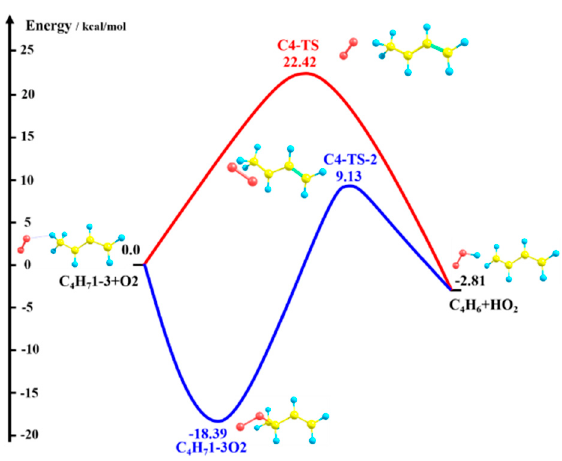
Figure 3. Potential energy surface (PES) for the Ċ 4 H 7 1-3 + O 2 reaction.